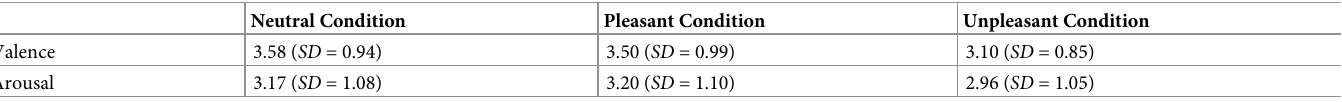
Table 3. Ratings of valence and arousal across neutral, pleasant, and unpleasant context conditions for face stimuli (1–9 scales from “negative” to “positive” for valence and “calm” to “excited” for